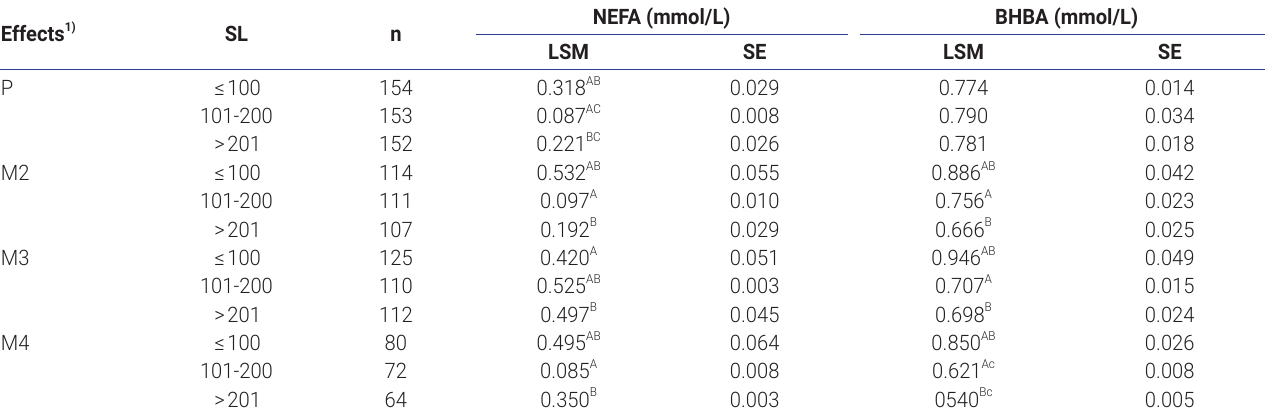
Table 4. The effect of parity number and lactation stage on the level of nonesterified fatty acid and β-hydroxybutyrate acid in cow blood